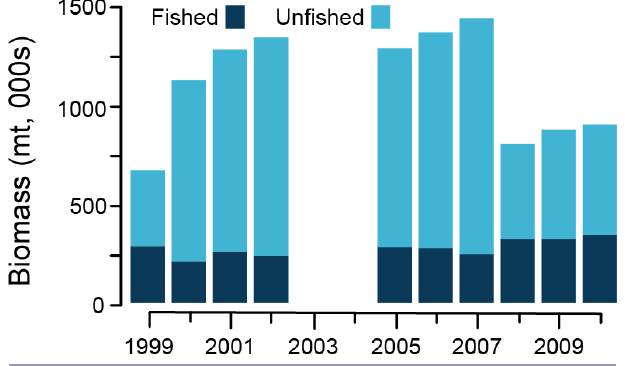
Fig. 8 . Possible conflict threshold effect from changes in